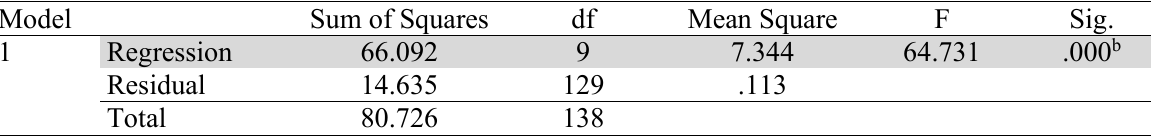
The results of the Anova a